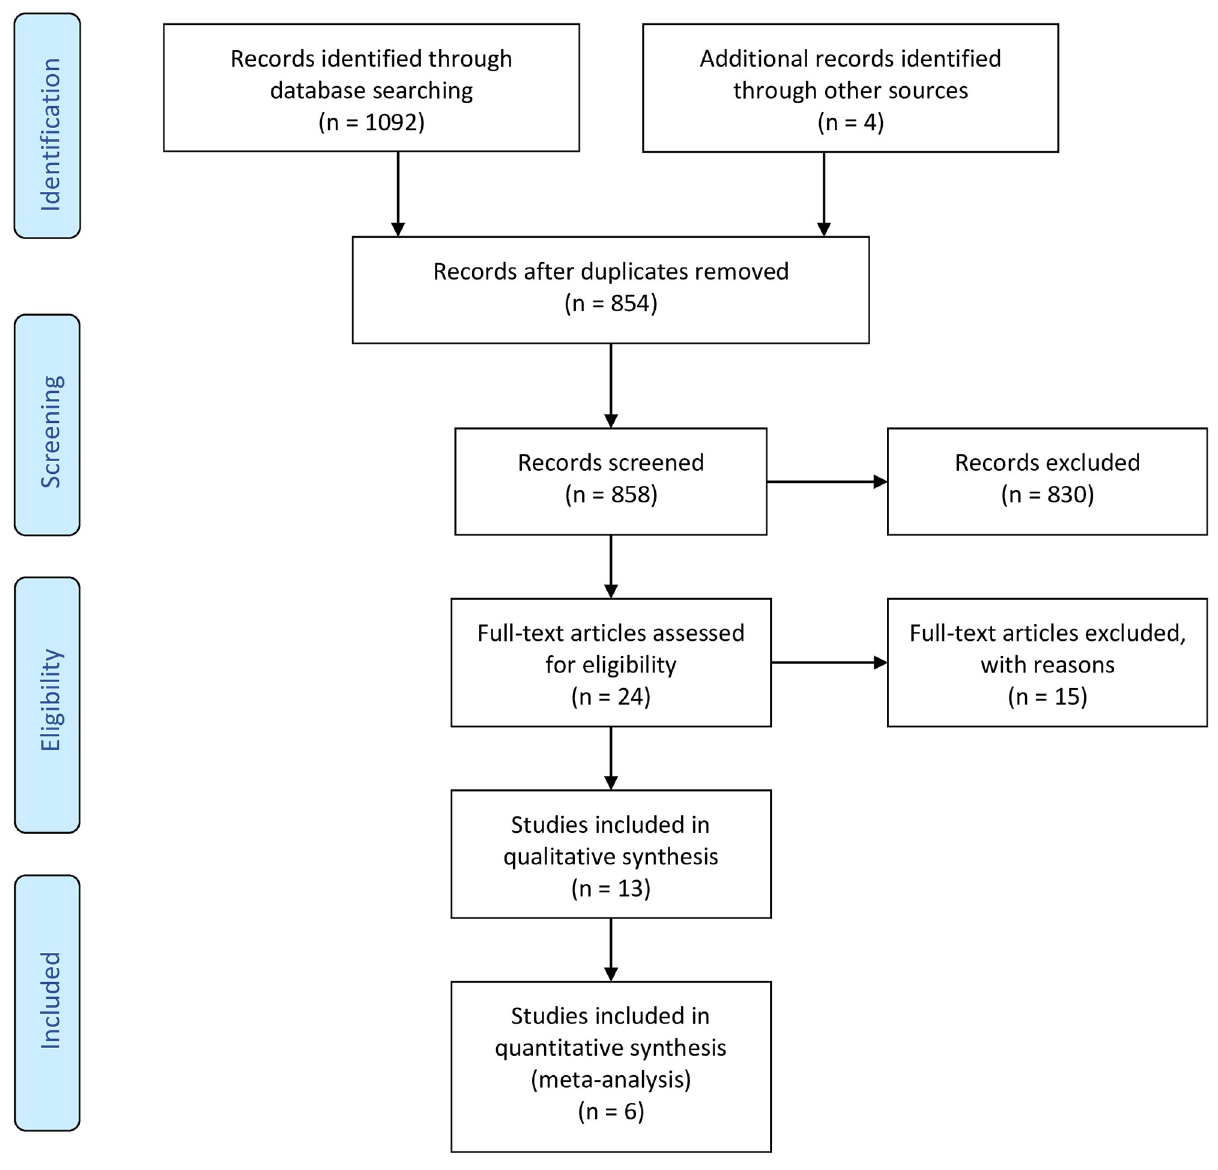
Fig 1. PRISMA study selection flow diagram